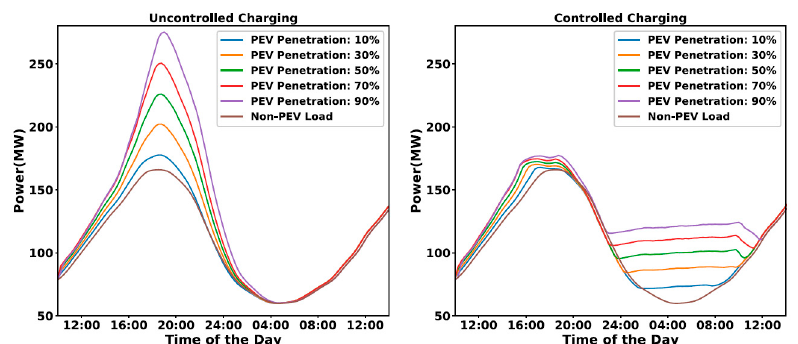
Figure 1. Residential power load for uncontrolled and controlled charging under different plug-in electric vehicle (PEV) penetration levels (PEVs in the study are all battery electric vehicles (BEVs)) [21].